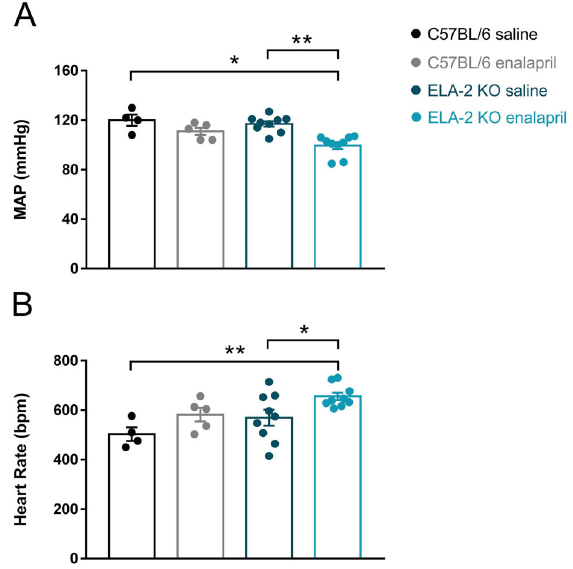
Figure 2. Basal mean arterial pressure (MAP) and heart rate of knock-out mice (ELA-2 KO) and wild-type mice (C57BL/6) treated with saline or enalapril. A , Enalapril treatment for 10 days signi fi cantly reduced ELA-2 KO mice MAP compared to the saline group. B , Heart rate was slightly increased after 10 days of treatment with the ACE inhibitor. Data are reported as means ± SE. **P o 0.005, *P o 0.05, two-way